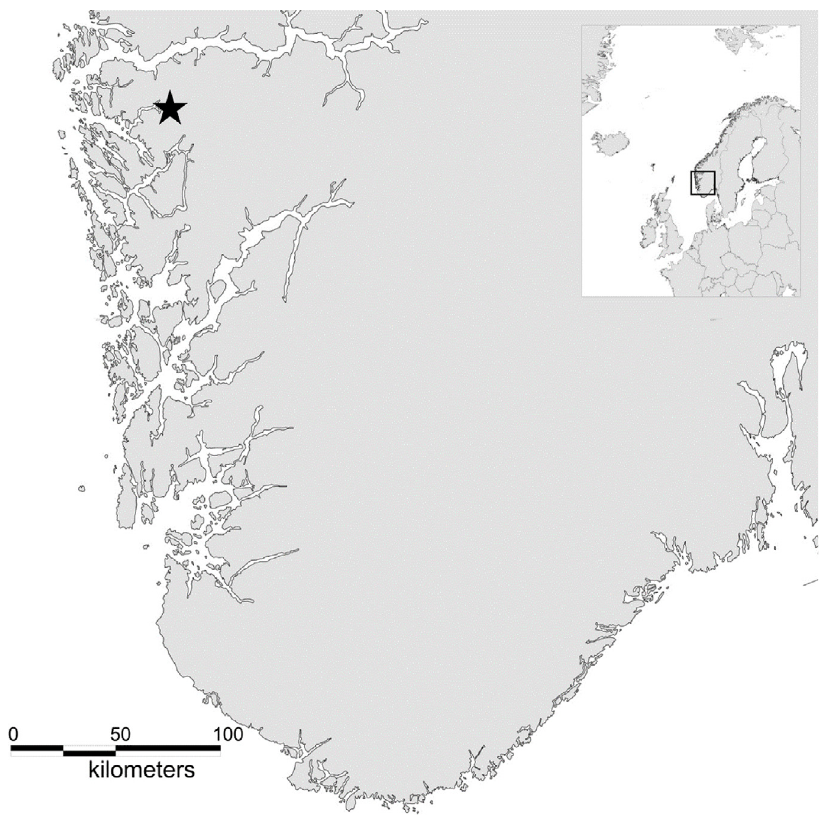
Fig. 1. Map showing the location of the aquaculture sites Smørdalen and Solheim, western Norway (black star) where the present wild fi sh were documented inside sea-cages stocked with farmed Atlantic salmon ( Salmo salar L.). The sites are located 6000 m